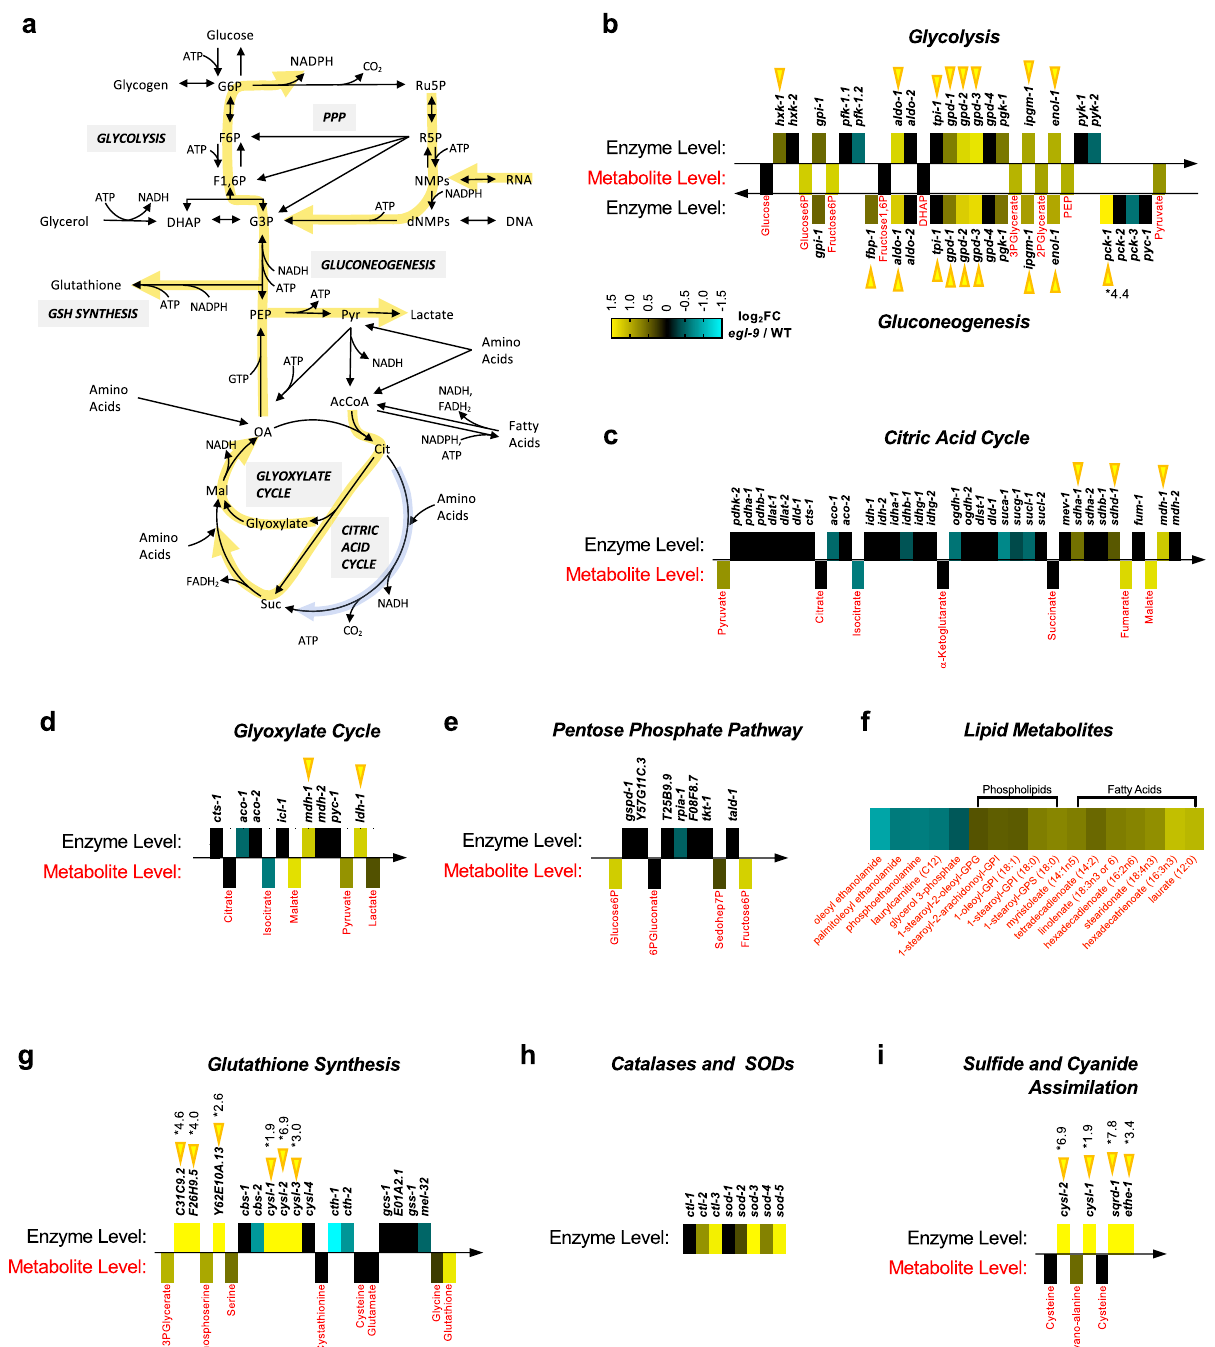
Fig.3| HIF-1reprogramsmetabolism.a Overviewof majormetabolicpathways impacted by HIF-1 activation. Yellow and cyan arrows overlaying the pathways indicate upregulation or downregulation, respectively, in egl-9 mutants rela- tive to wild type. b – i Combined heatmap for metabolites (red text) and the enzymes(blacktext)anddirectionalpathways(arrows)knowntoregulatetheir metabolism. The color index in ( b ) is applicable to all panels in the fi gure. On one side of each pathway arrow (above for most arrows except gluconeogen- esis), differentially colored boxes indicate enzyme mRNA expression levels (log 2 fold change)in egl-9 mutants relative to wild type;enzymes are labeled in